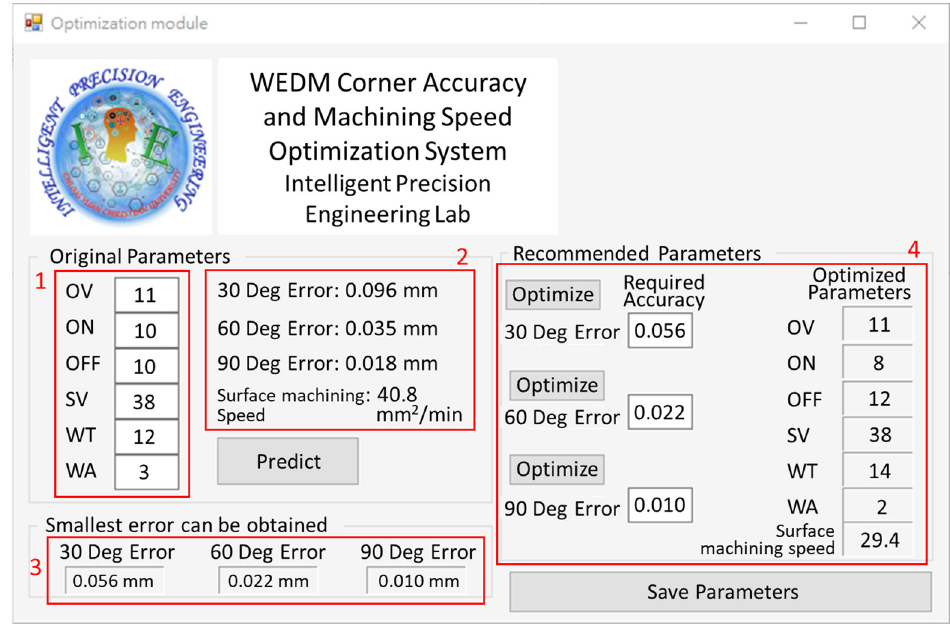
Figure 10. WEDM corner accuracy and machining speed optimization human–machine interface.